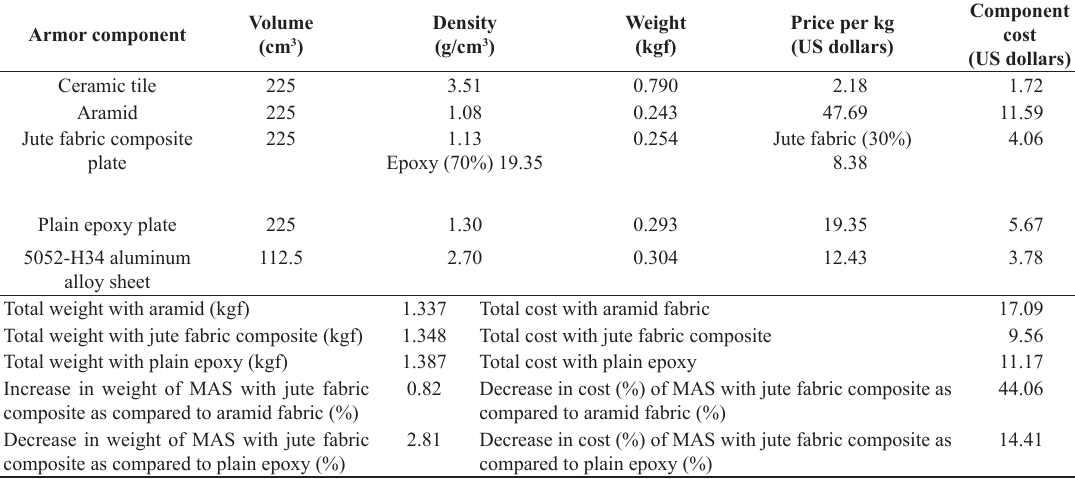
Table 3. Evaluation of weight and cost of the different multilayered armor components. Armor